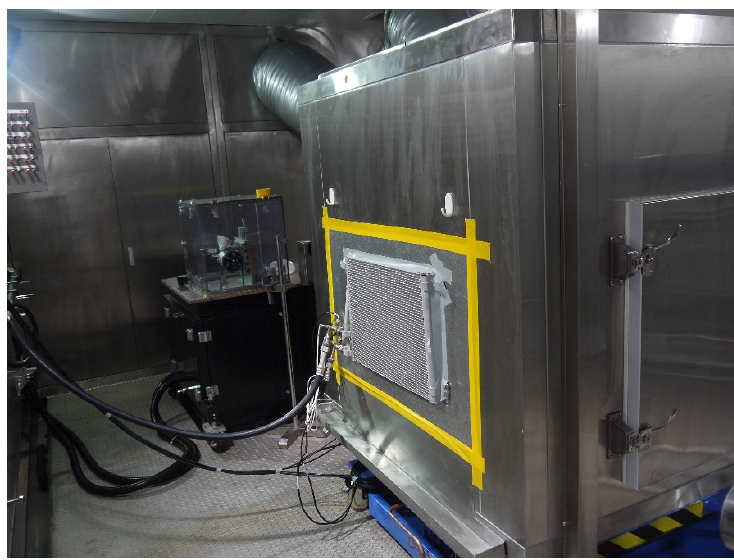
Figure 5. The heat exchanger performance test platform.